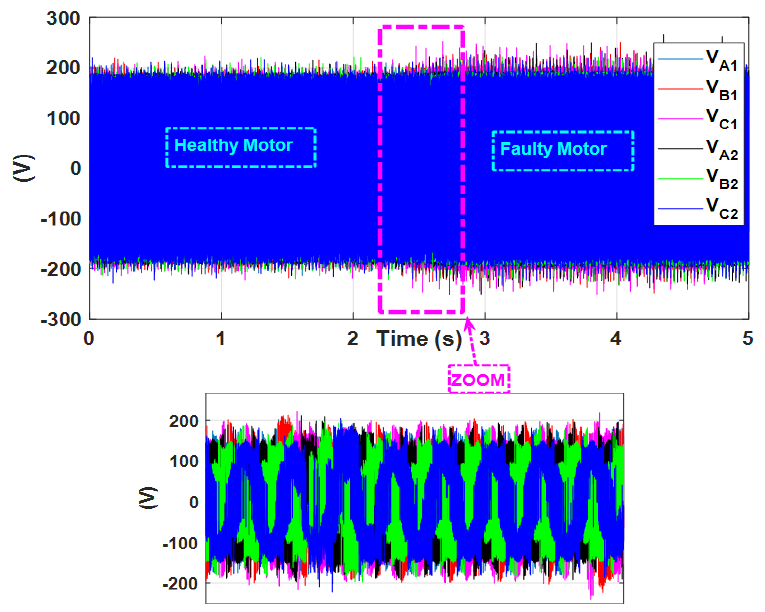
Figure 15. ASPIM voltages in the presence of ITSCF conditions.